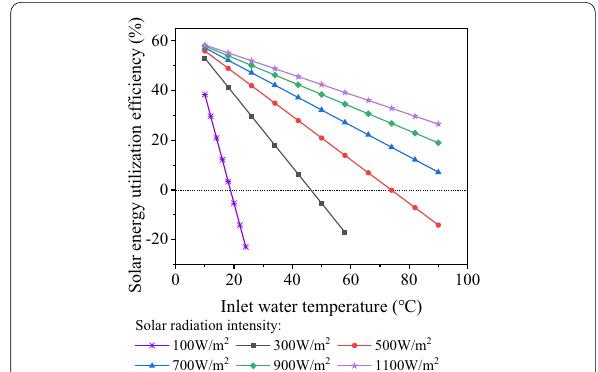
Fig. 7 Effect of inlet water temperature on solar energy utilization